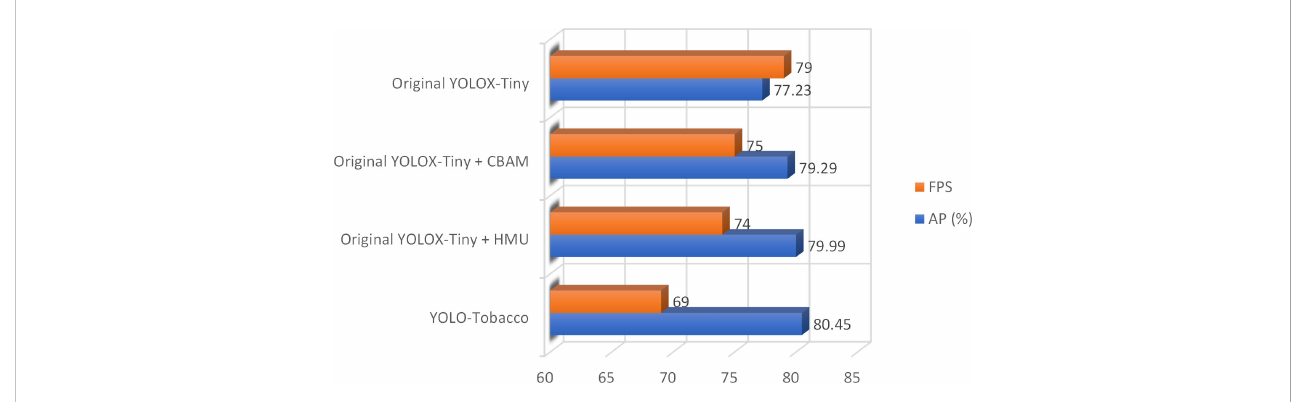
FIGURE 8 Comparison of the results of the four tested